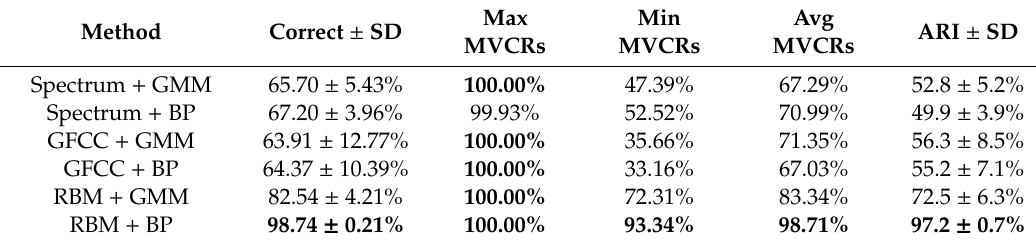
Table 4. Performance of clustering system on Dataset 1.